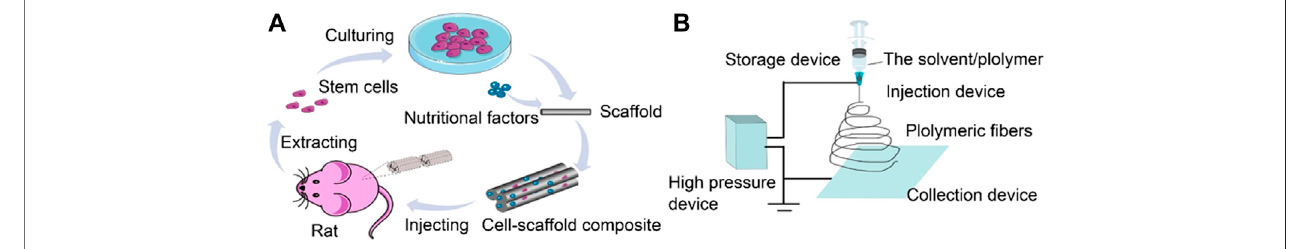
FIGURE 1 | (A) Schematic illustration of polymeric fi ber scaffolds encapsulating stem cells to be injected into SCI for neural tissue engineering. (B) Schematic illustration of electrospinning for polymeric fi ber scaffolds.